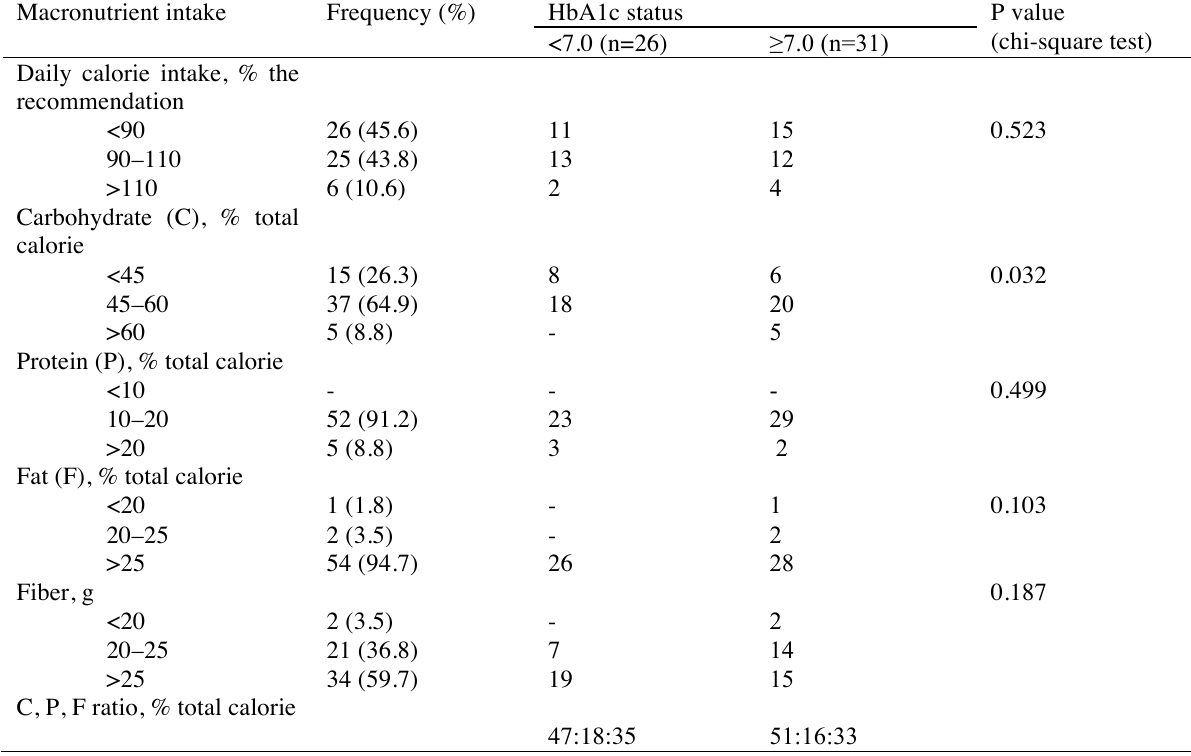
Table 2 Macronutrient intake of study subject and HbA1c status